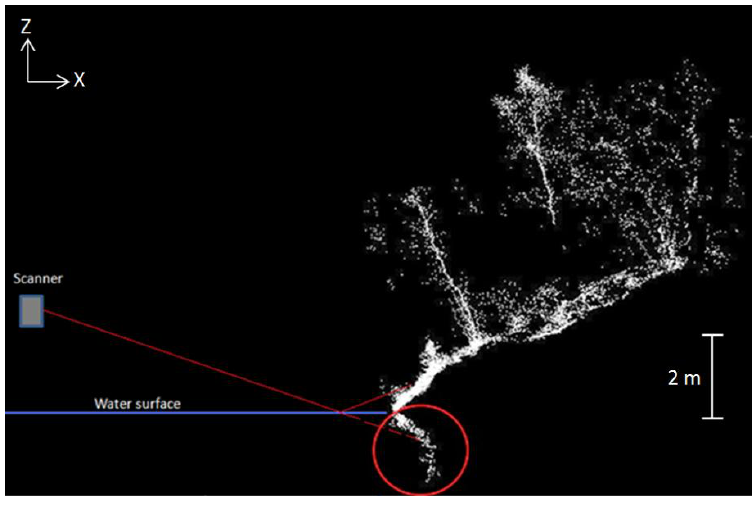
Figure 4. The point cloud profile demonstrates multipath reflections underneath the water